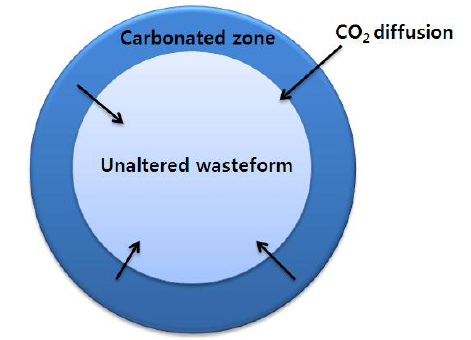
Figure 4. Schematic of carbonation showing a diffusion-controlling reaction (modified from Bin ‐ Shafique